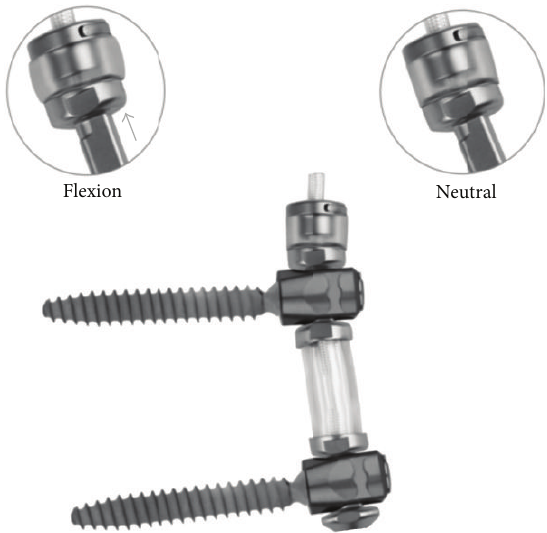
Figure 3: The TRANSITION Stabilization System. The cephalad bumper shown in neutral and flexed